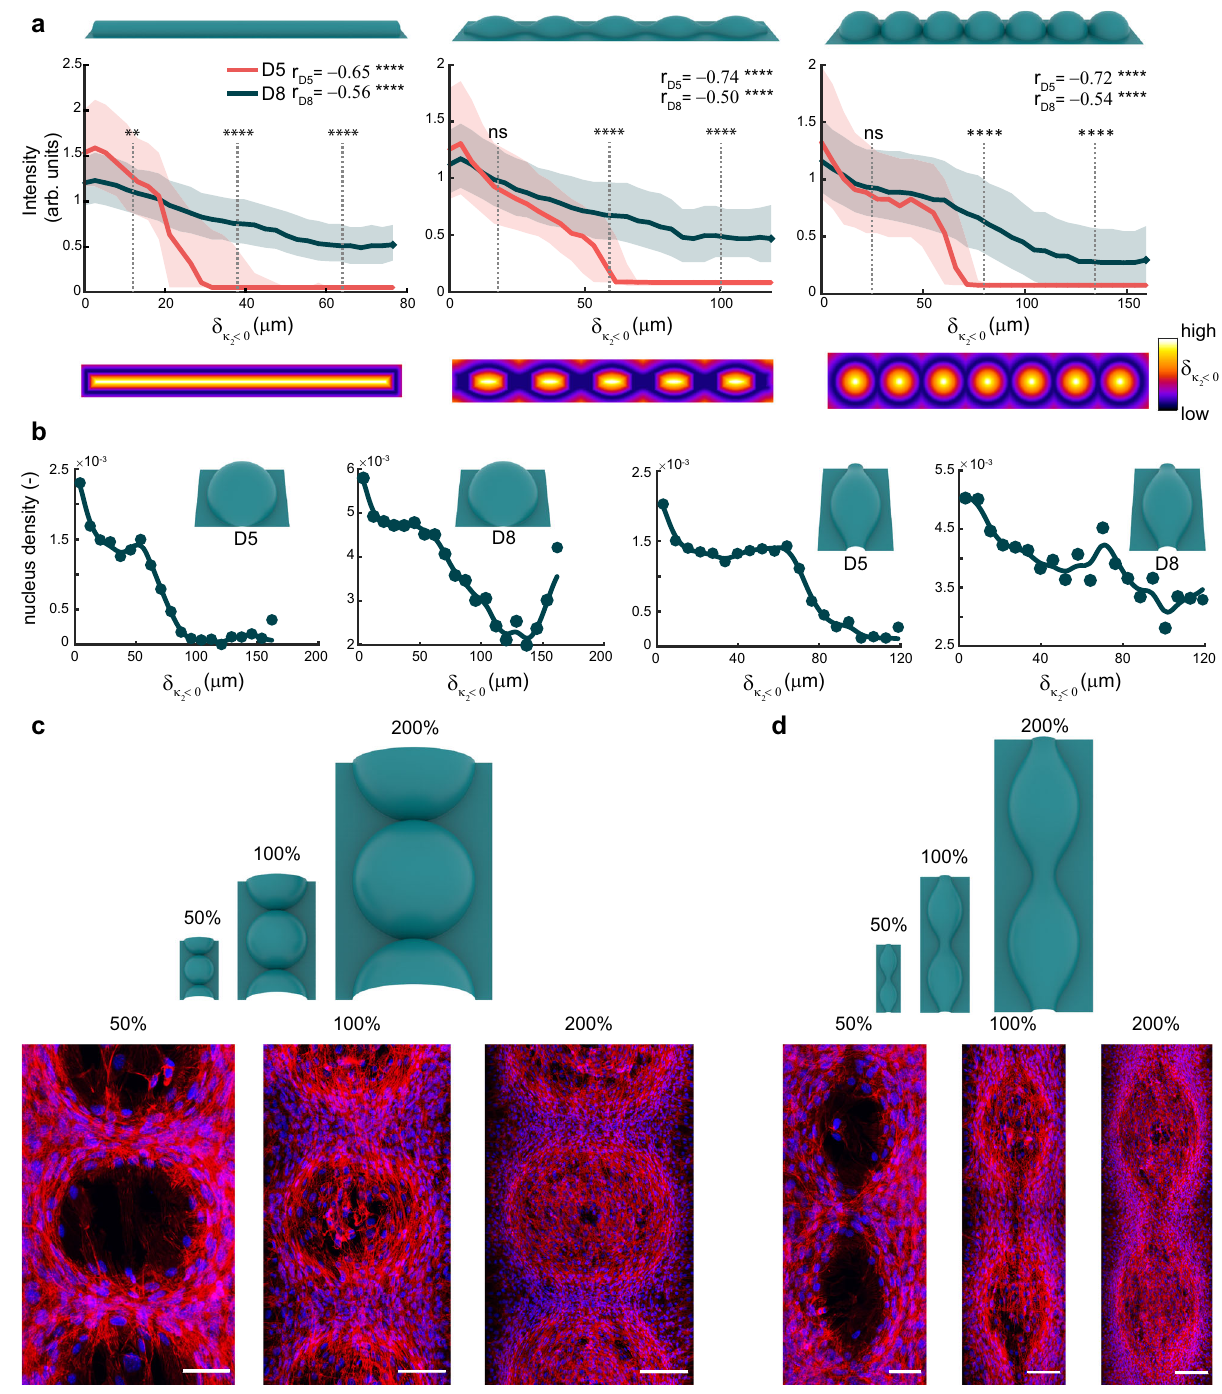
Fig.3|Patterningasafunctionof δ k andsubstratescale.a NormalizedF-actin b Nucleus density (number of nuclei at a given δ κ normalized by number of 2 < 0 2 <0 for three convex substrates at day 5 and 8. The solid line )versus δ κ fortheday5andday8datapresented intensity versus δ κ regionswiththatvalueof δ κ 2 <0 2 <0 2 <0 represents the median value, while the shaded areas correspond to the inter- in Fig. 2f, g. The curve through the data points is a smoothing spline. c Repre- quartilerange.Ther-valuesrepresenttheSpearman ’ scorrelationcoef fi cients.Two- sentative maximum intensity projections of merged F-actin (red) and DNA (blue) tailed Mann – Whitney U tests: ** p =0.0025, **** p <0.0001, ns=not signi fi cant. The immunostainings at day 8 on scaled versions of the convex spherical substrates bottomrowdepictstheEuclideandistancemapsforthethreeconsidered(convex) (100% being the original scale). d The same as in c but for the scaled convex substrates. Combined data from n =4 independent experiments for D8, n =3 for unduloid substrate. Scale bars are 50 µ m (50% scale), 100 µ m (100% scale), and D5 spheres and unduloid, n =1 for D5 cylinder (representative of 3 cylinders). 200 µ m (200% scale). Source data are provided as a Source Data fi